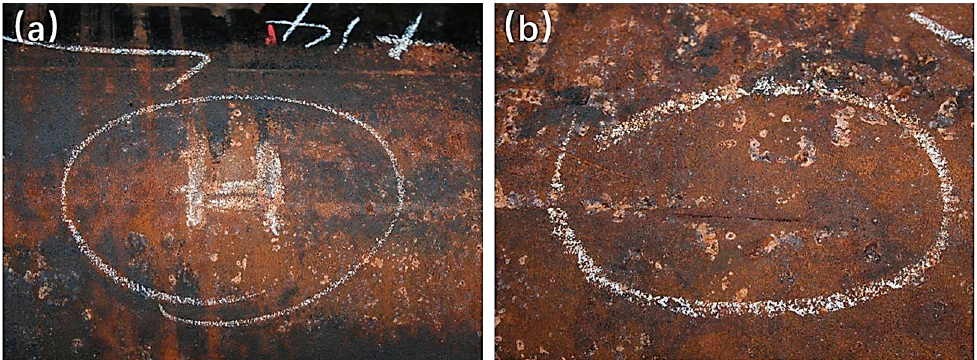
Figure 1. Morphology of leaking pipes ( a ) 1# pipe and ( b ) 2# pipe.